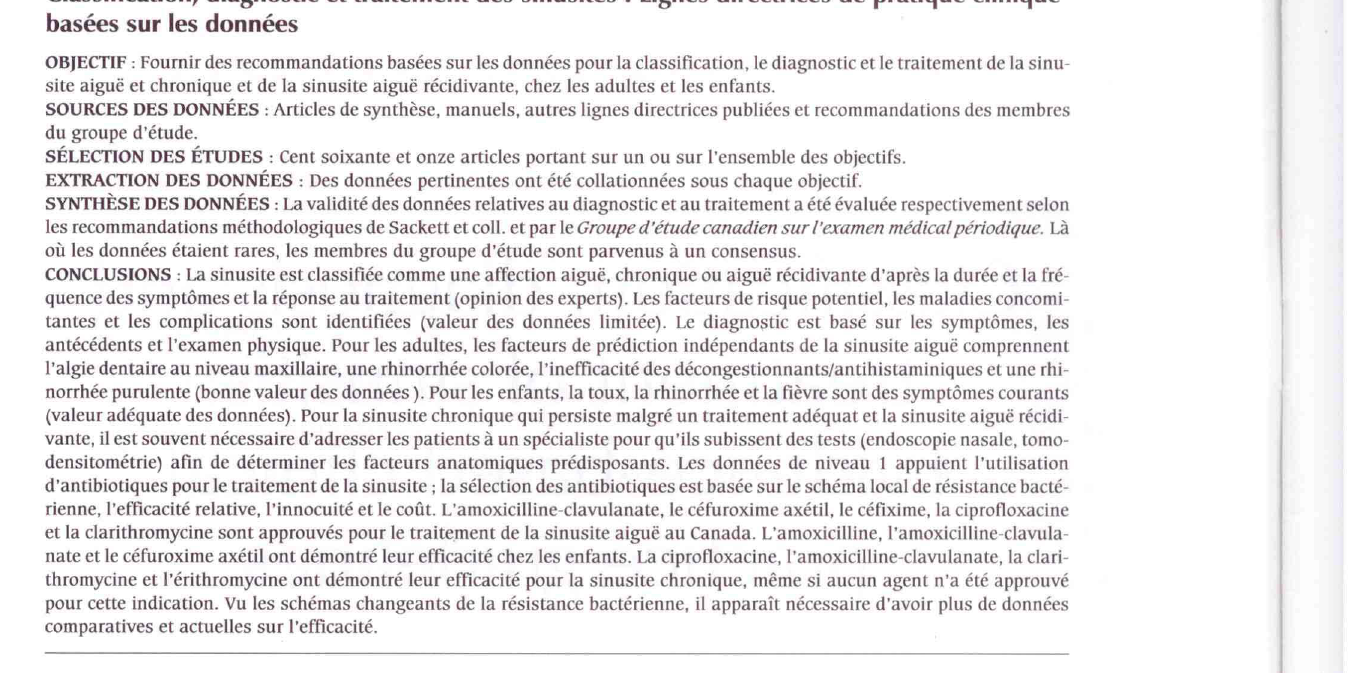
Classification, diagnostic et traitement des sinusites : lignes directrices de pratique clinique basees sur les